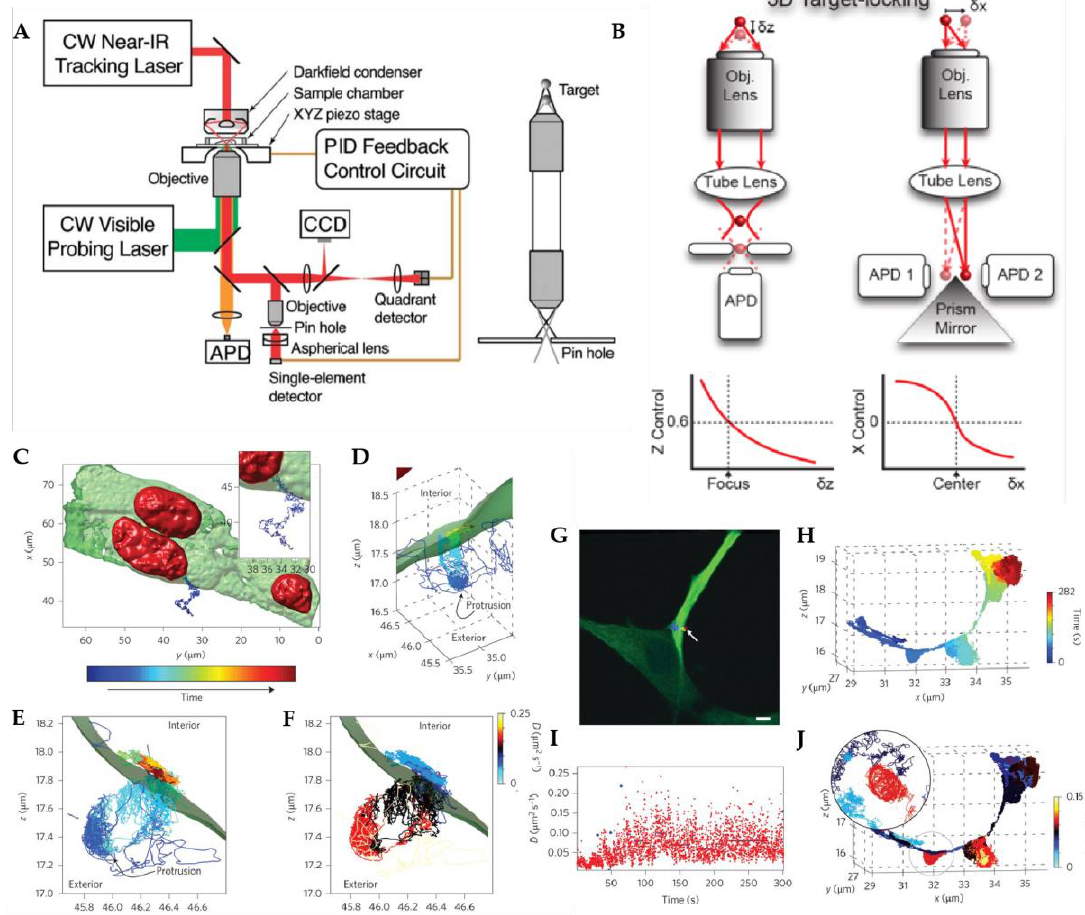
Figure 5. Multi-detector active feedback 3D tracking. ( A ) Schematic of dark-field multi-detector active feedback tracking system developed by Cang et al. which utilized a quadrant photodiode. Reprinted from reference [72], with the permission of AIP Publishing. ( B ) Schematic of multi-detector setup used for fluorescent nanoparticle tracking. ( C ) Top-down view of a polystyrene-quantum dot-peptide nanoparticle (PS-QD-peptide) landing on a membrane protrusion of a live cell. ( D , E ) High-resolution view of trajectory in ( C ) with di ff erent angles. ( F ) Dynamics heat map of the trajectory, showing regions of varying particle di ff usivity depending on its location on the nanoscale protrusion ( C ). ( G ) Overlaid image of two-photon live cell image and high-resolution 2D trajectory. ( H ) High-resolution 3D trajectory of a PS-QD-peptide as it traces out hemispherically-capped protrusions on the live cell membrane. ( I ) Di ff usional states as a function of time analyzed by change-point di ff usion analysis. ( J ) Dynamics heat map of trajectory in ( H ). Adapted from reference [76] with permission of the author.